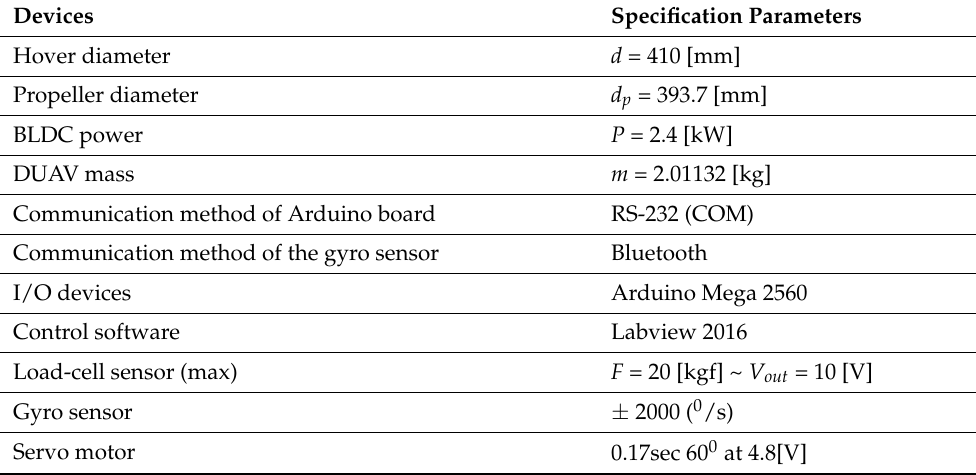
Table 3. The specification of DUAV apparatus.